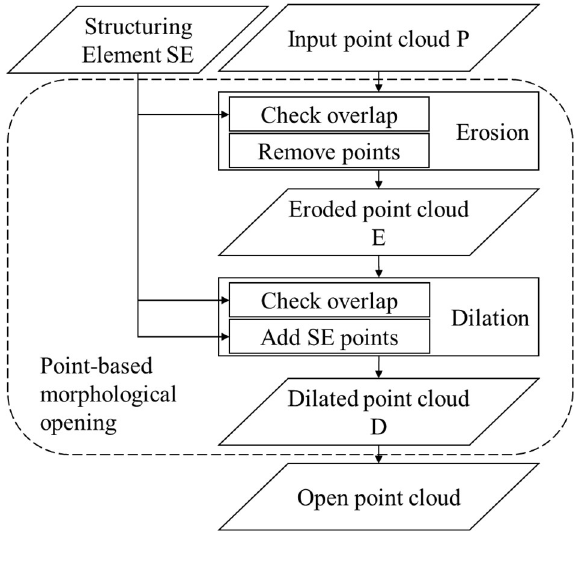
Figure 1 . Data workflow of the morphological